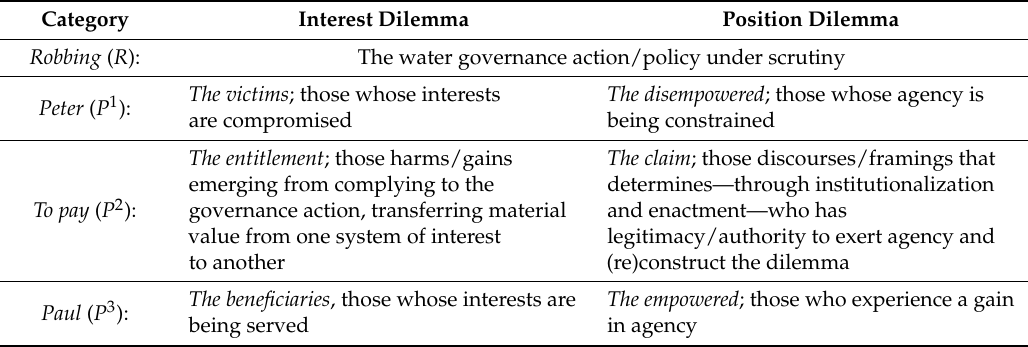
Table 1. The RP3S